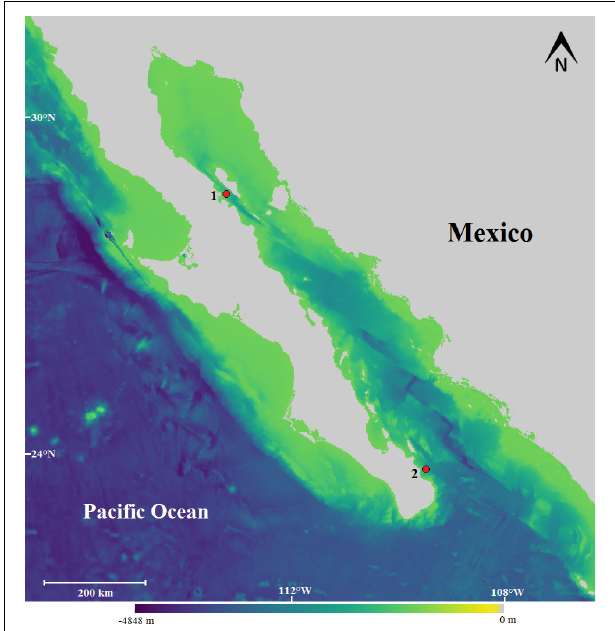
FIGURE 1 | Location of the recording sites of Bryde’s whale calls in the north from November 2006 to June 2007 and south from August to December 2008 within the Gulf of California. (1) Bahía de los Ángeles, Baja California and (2) Punta Pescadero, Baja California Sur, Mexico. Bathymetry is also